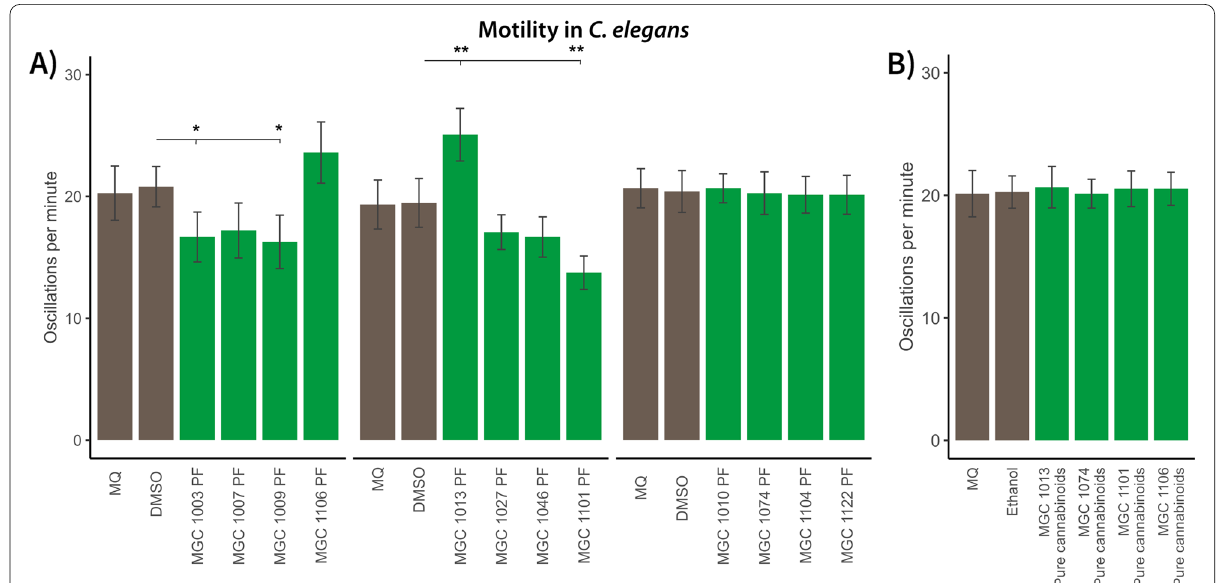
Fig. 4 Effect of polar fractions (PFs) from different varieties on C. elegans motility. The number of full body bends (oscillations) per minute is used as measure for motility after treatment with different varieties from L1 to young adult stage. A effect on motility after exposure of C. elegans to 100 μg/mL PFs of all varieties used in this study: MGC 1003, MGC 1009, and MGC 1101 induce reduced motility in C. elegans after treatment, MGC 1013 increased motility; B effect on motility after exposure of C. elegans to pure cannabinoids containing 0.0143 μg/mL cannabidiol (CBD) (similar to the concentration in the polar fraction (PF) of MGC 1101), pure cannabinoids containing 0.0125 μg/mL CBD (similar to the concentration in the PF of MGC 1074), pure cannabinoids contain 0.0262 μg/mL Δ 9 ‑tetrahydrocannabinol acid (THCA) and 0.0133 μg/mL Δ 9 ‑tetrahydrocannabinol (THC) (similar to the concentration in the PF of MGC 1101), and pure cannabinoids contain 0.0278 μg/mL THCA & 0.0140 μg/mL THC (similar to the concentration in the PF of MGC 1106). Mann‑Whitney U tests were used to compare the vehicle control conditions Dimethyl sulfoxide (DMSO) to the experimental conditions. Milli‑Q (MQ) is the water control. Green bars denote motility of C. elegans exposed to PFs of different cannabis varieties; brown bars denote vehicles; ** false discovery rate (FDR)‑corrected p < .01; * FDR‑corrected p < = =